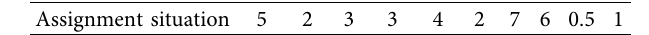
Table 8: Assignment of parameters. Parameter